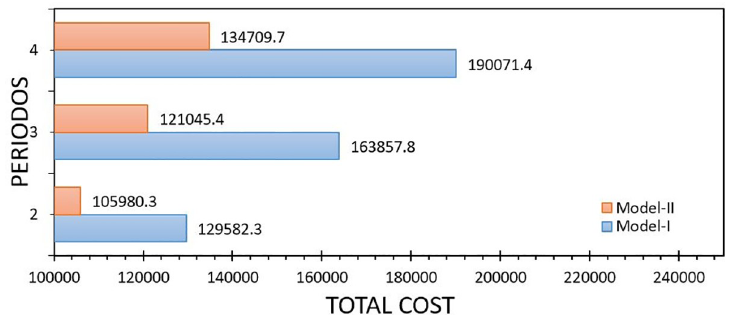
Fig 5. Comparison between Model-I and Model-II with respect to the expected value for perfect information. Own elaboration.